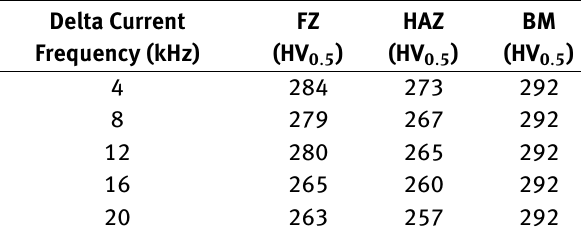
Table 9: Effect of DCF on microhardness of various regions Delta